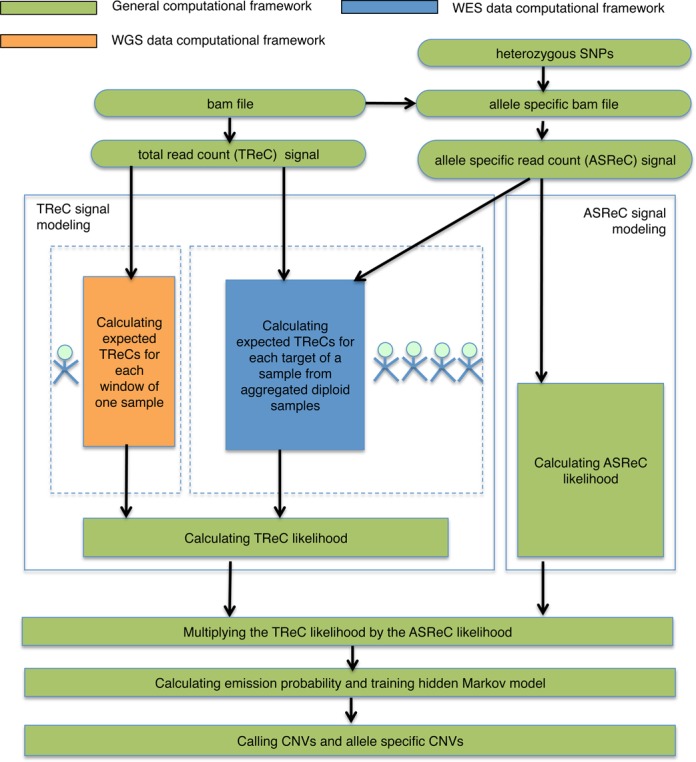
Method overview. Our method is a hidden Markov model-based algorithm. We compute the total read count (TReC) and allele-specific read count (ASReC) from the alignments (.bam file) and the allele-specific alignments at each genomic region (i.e. a window or a target). To infer the underlying copy number, we calculate the likelihood of the observed TReC and the ASReC from the estimated expected TReC for each possible underlying copy number. We calculate the likelihoods of TReC and ASReC separately. For the TReC likelihood, the calculations for whole-genome sequencing (WGS) data and whole-exome sequencing (WES) data are different. For WGS, we estimate the expected TReC using one sample; for WES, we estimate the expected TReC by aggregating multiple samples. In addition to calculating the TReC likelihood, we also utilize the ASReC likelihood in order to improve CNV-detection performance. We insert the product of the two likelihoods into the hidden Markov-model emission probability. After this training, we call CNV by identifying the change of the most likely underlying copy number as the CNV breakpoint. We call allele-specific CNV by choosing the most likely allelic configuration for each CNV.